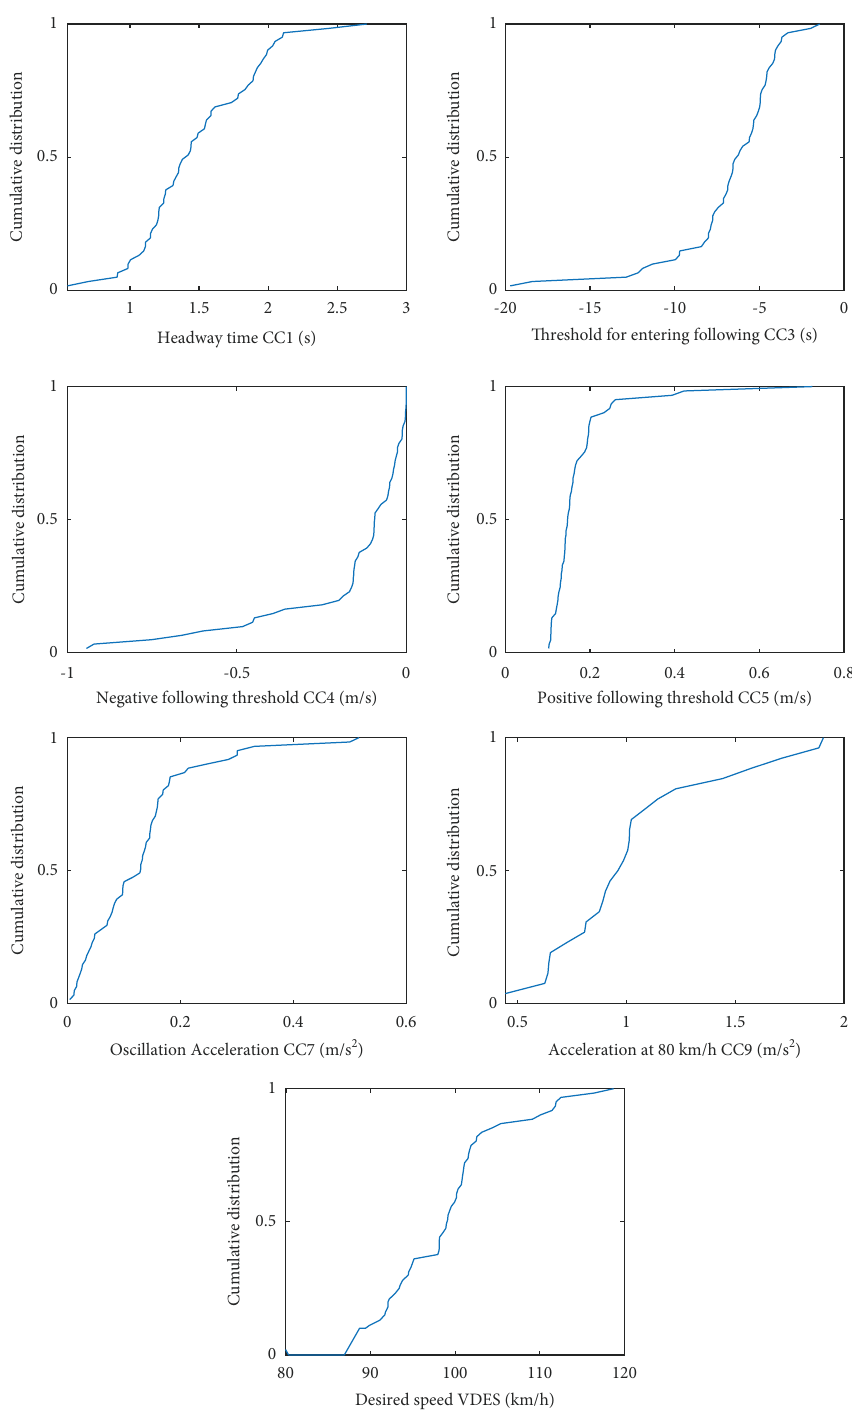
Figure 6: Cumulative distribution of parameter estimates for the Wiedemann 99 car-following